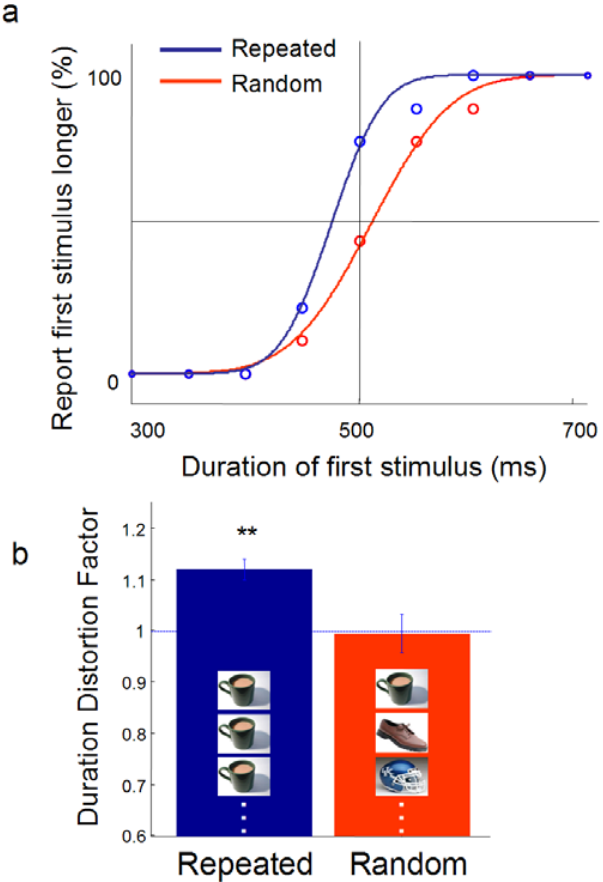
Figure 4. The debut effect disappears with random stimuli. (a) Participants reported whether the first stimulus in a series of repeated or random images appeared longer than the following ones. Representative data from one participant shown. (b) Mean DDF values for the repeated and random series (n=6). The debut effect only occurs when stimuli are repeated (p , 6 6 10 2 4 ), implicating the role of predictability. Error bars SEM. n=8.